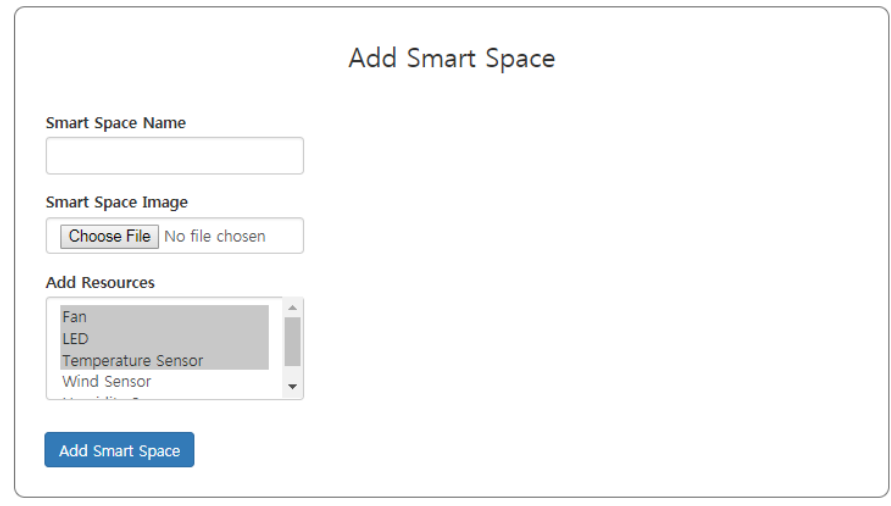
Figure 13. Add smart space